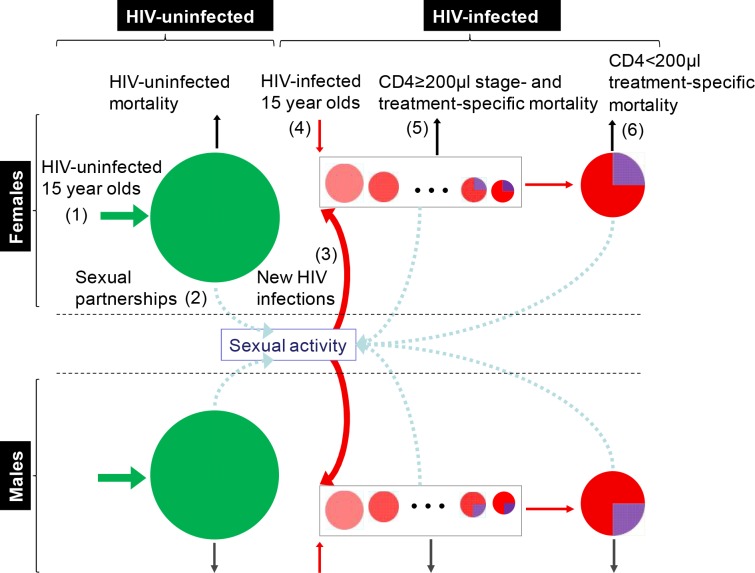
The HIV infections model.New 15-year-old HIV-uninfected individuals flow into the HIV-uninfected pools (1). HIV-uninfected individuals participate in sexual activity with HIV-uninfected and HIV-infected individuals (2), giving rise to new HIV infections (3), which together with new HIV-infected 15-year-olds (4) add to the HIV-infected pool. HIV-infected people progress through different stages of HIV infection (5) until reaching CD4 cell count < 200μl (6) (purple color indicates people receiving ART).